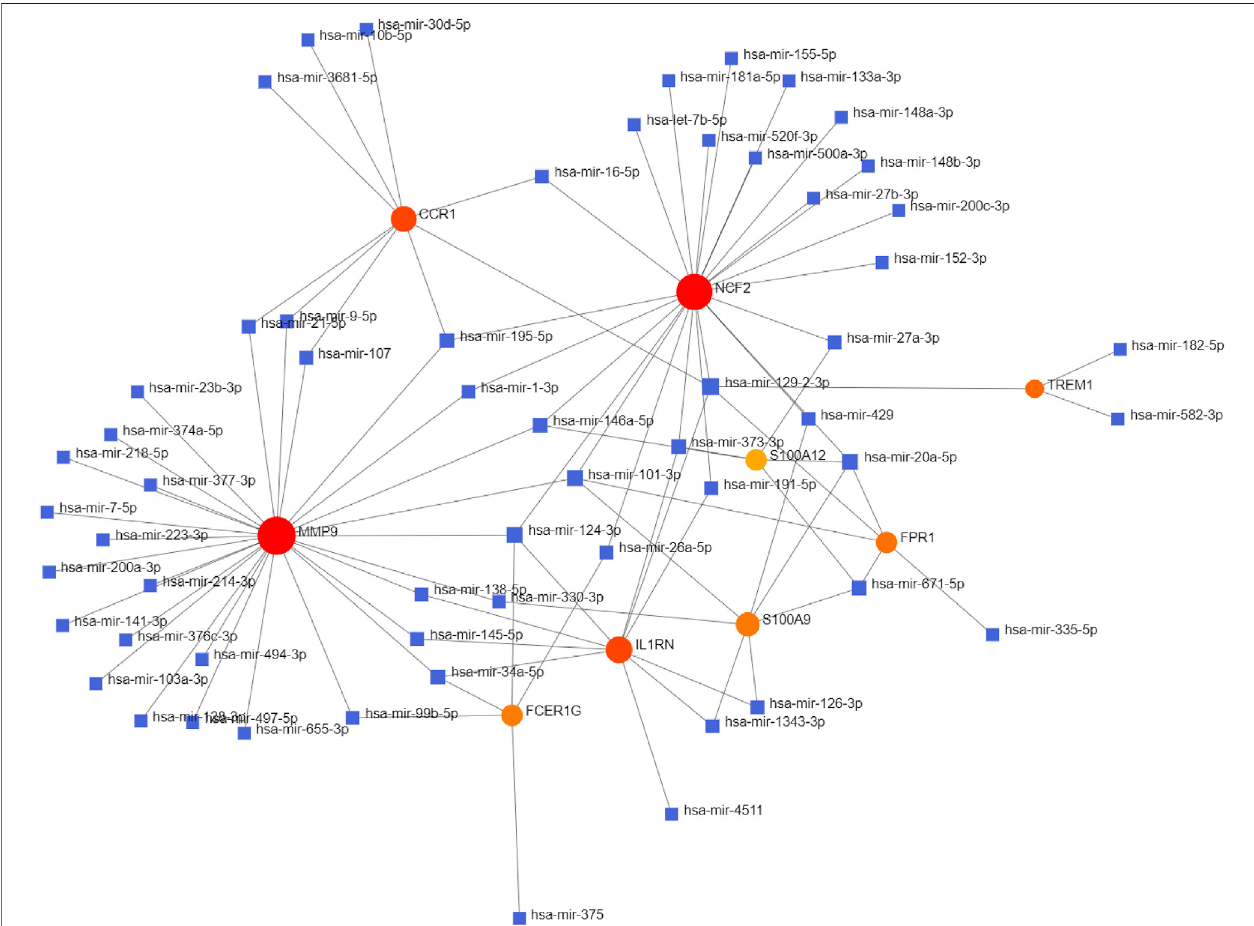
FIGURE 6 | Integrated miRNA-gene interaction networks for the nine hub genes. Red circles represent nine hub genes. Blue squares represent miRNA which has connectivity with hub genes. Abbreviations: miRNA, microRNA.